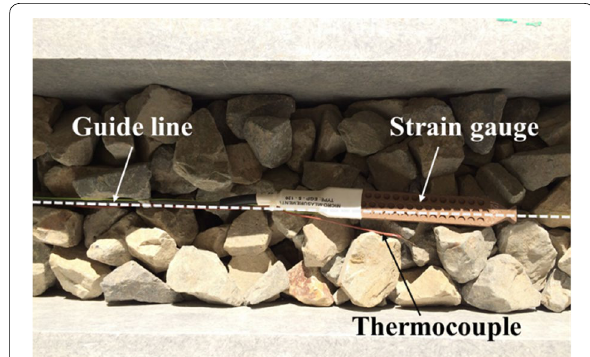
Fig. 10 Installation of strain gauge and thermocouple for shrinkage tests.